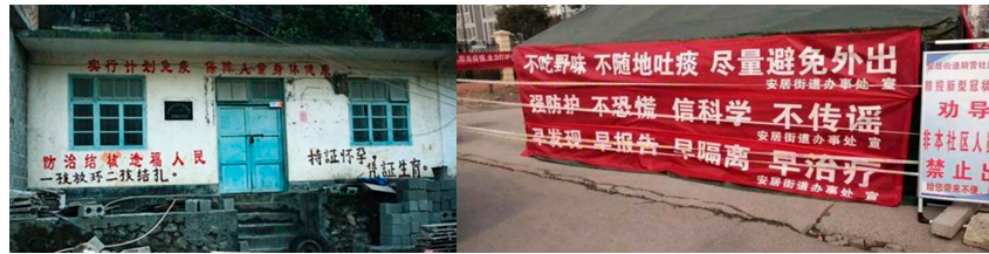
Figure 1. Banners on the wall of a house ( left ); Anti-Covid-19 banners ( right ).